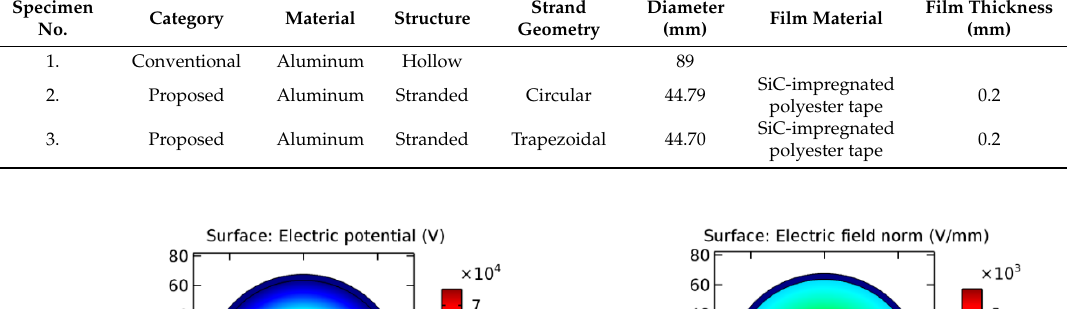
Table 3. Conductor specimens used in the comparative appraisal.